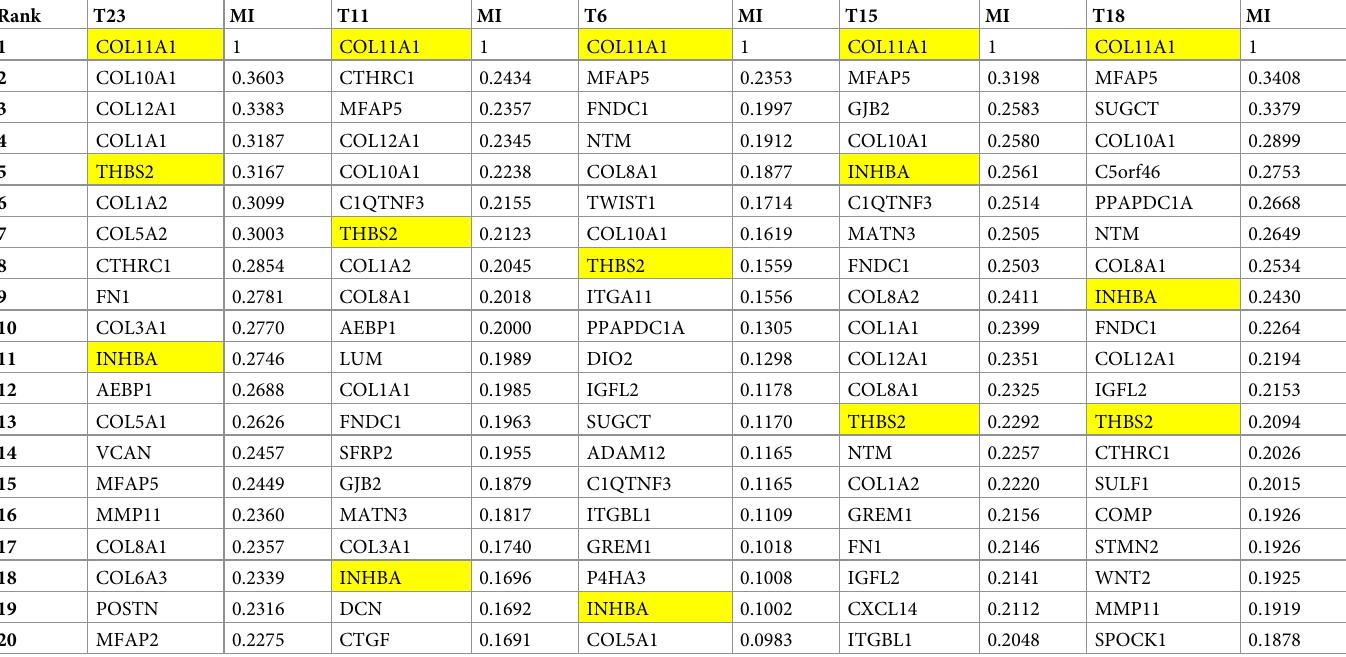
Table 4. Ranked COL11A1 -associated genes in five PDAC samples. MI = Mutual